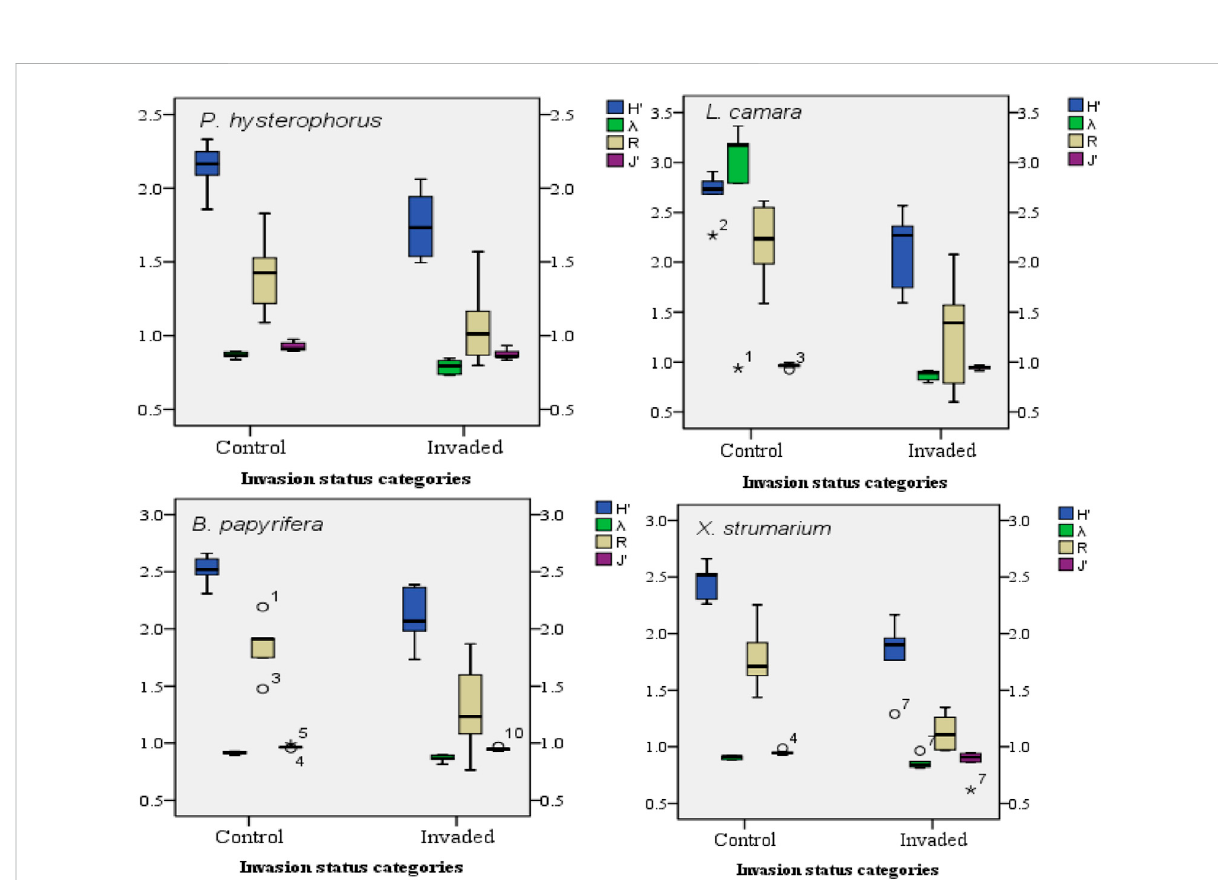
R = Margalef ’ s index of species richness; H ’ = Shannon index of diversity; J ’ = Species evenness; λ = Simpson index of